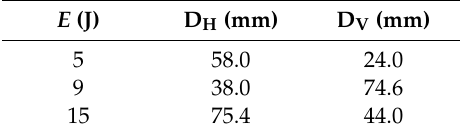
Table 3. Values of D H and D V for the PC2B specimen through LT